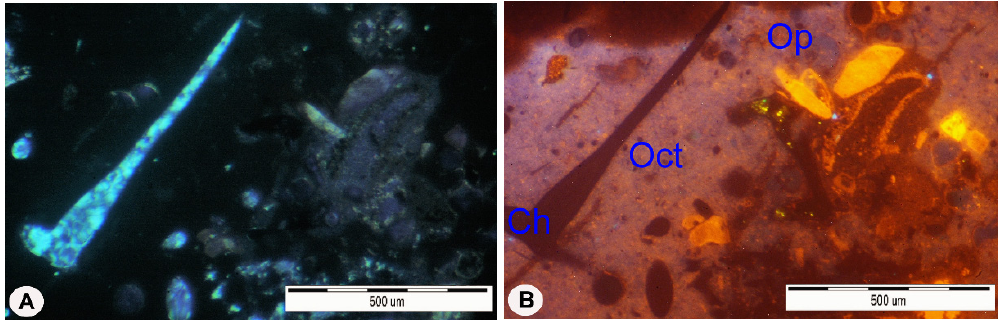
Figure 7. The silificated opoka-rock: ( A ) Polarizing microscope, 2P; ( B ) CL image revealing an opal rocky background–pink luminescence, and relics of feldspar and carbonate. Explanation of symbols: CL–cathodoluminescence, Ch–microcrystalline chalcedony, Oct–opal cristobalite–tridymite, Op–opal.